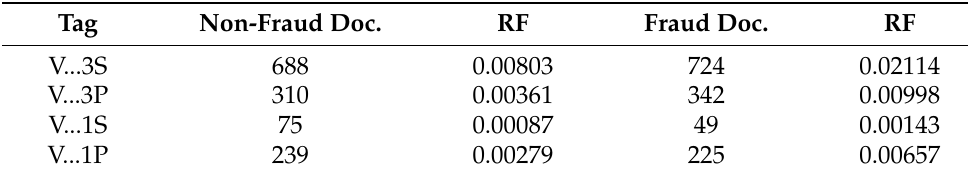
Table 2. The figures refer to absolute and relative frequencies (RF) of verbal forms of third and first, singular and